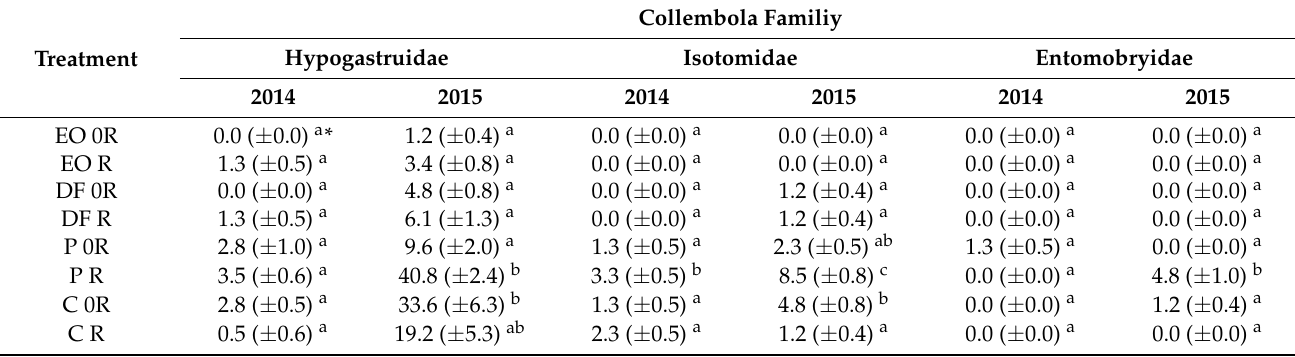
Table 4. The effect of petroleum-derived substances and the bioremediation process on the occurrence of individuals belonging to collembola families (Collembola)